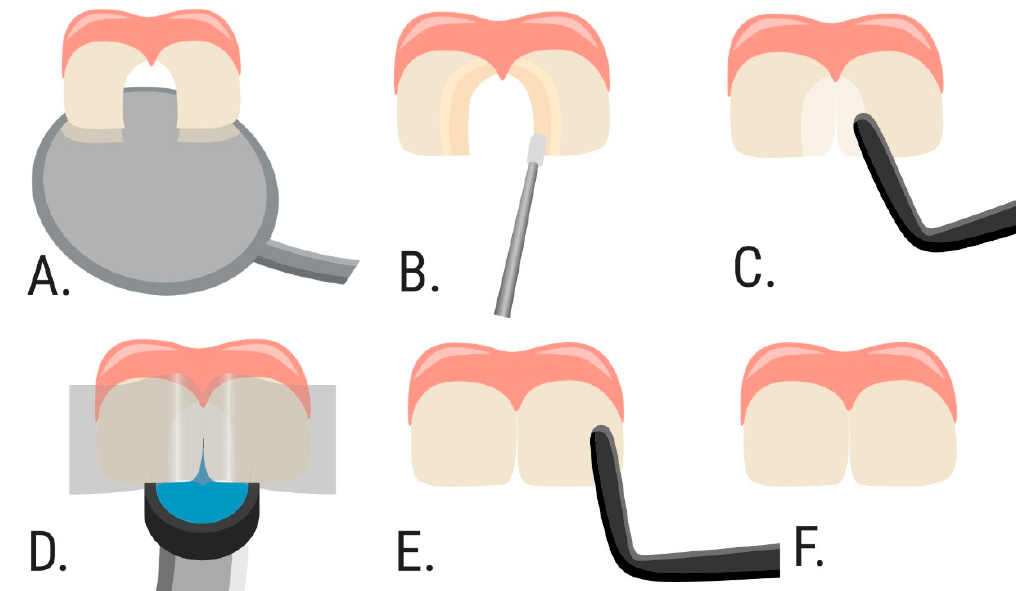
Figure 2. Schematic layout of class IV cavities restoration with an incremental layering technique, implemented in the